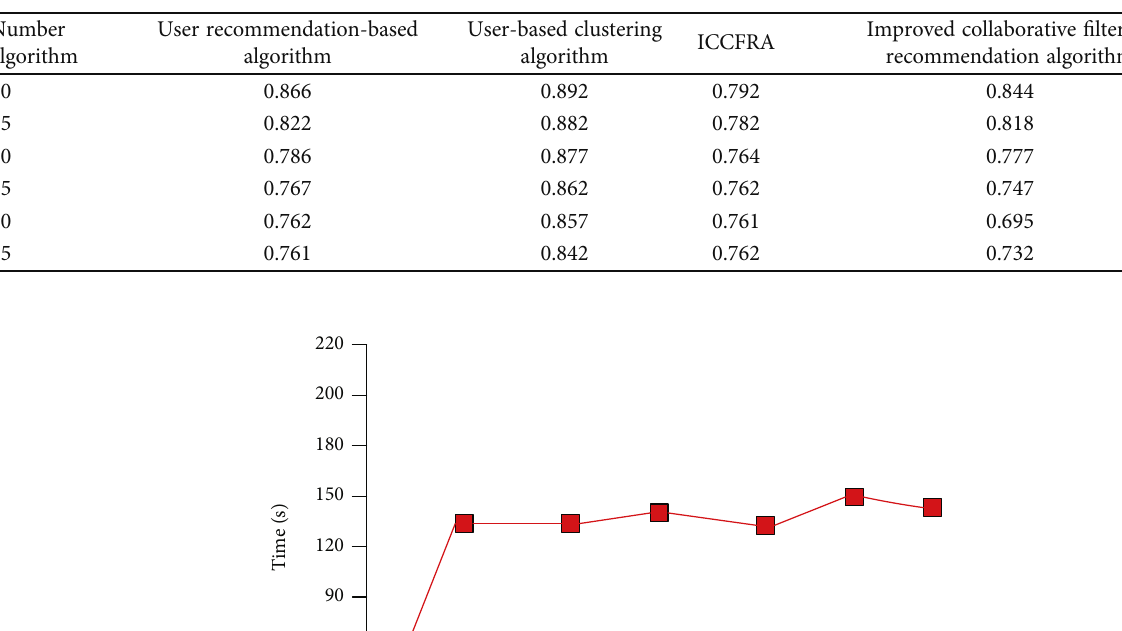
Table 6: Comparison of MAE results between the collaborative fi ltering recommendation algorithm based on bee colony K-means clustering and other three